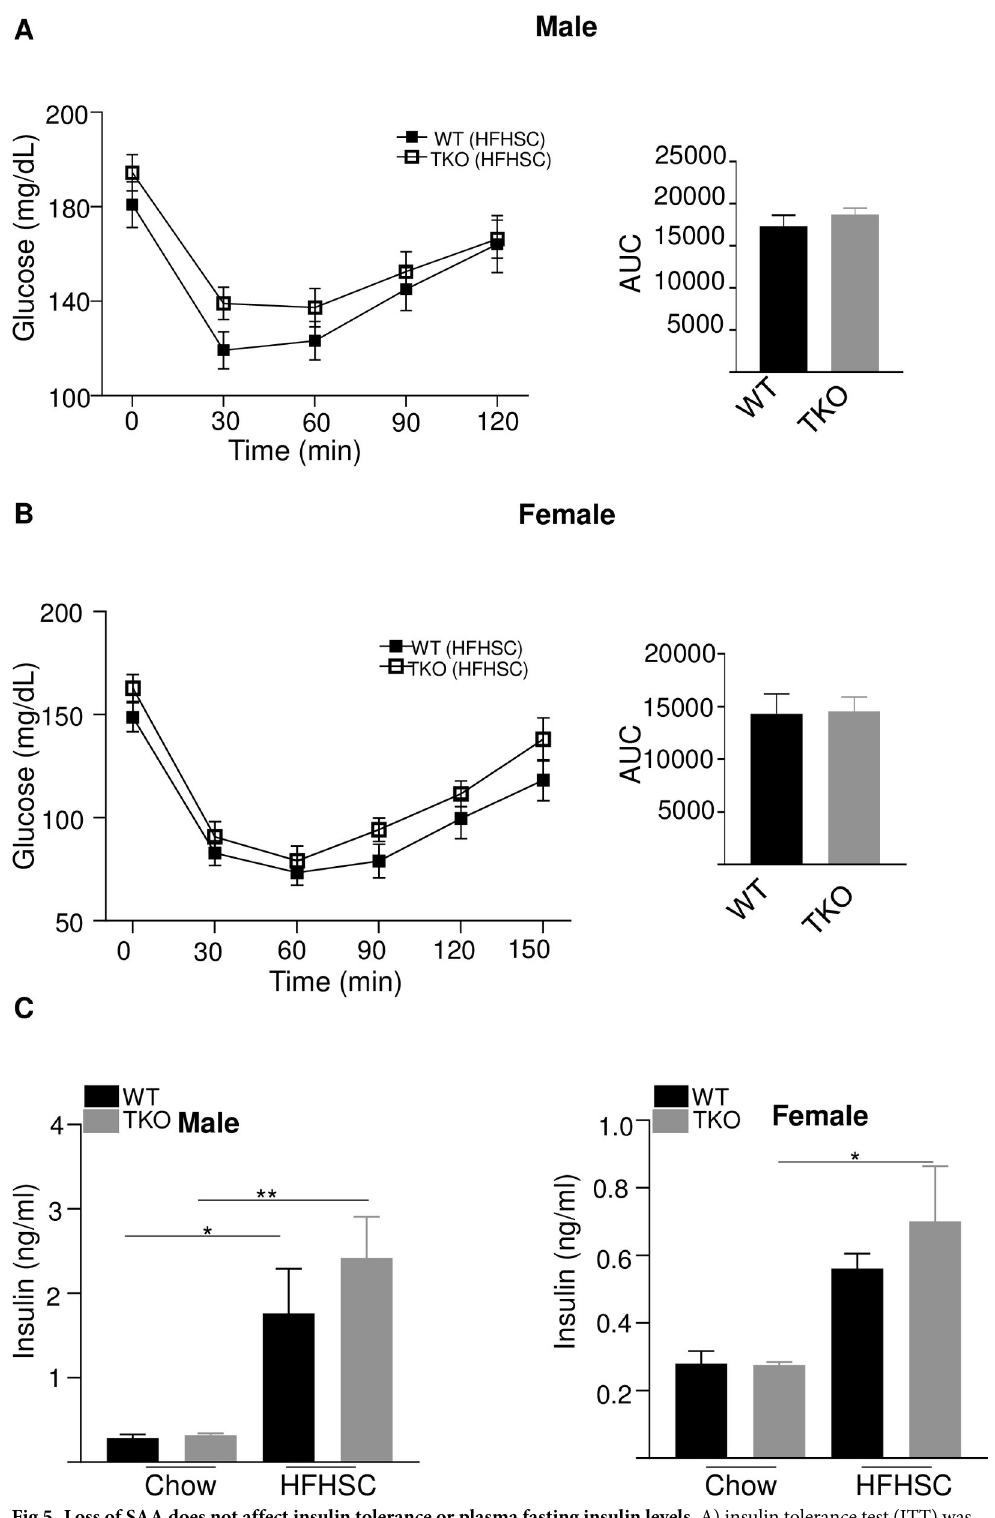
Fig 5. Loss of SAA does not affect insulin tolerance or plasma fasting insulin levels. A) insulin tolerance test (ITT) was performed in male WT and TKO mice after 13 weeks HFHSC diet (n = 10/group). AUC shown in the right panel B) insulin tolerance test (ITT) was performed in female WT and TKO mice after 13 weeks HFHSC diet (n = 10-15/group). AUC